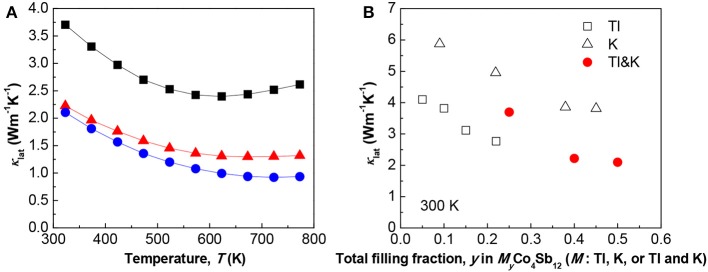
(A) Temperature dependence of the lattice thermal conductivity κlat of polycrystalline bulk samples of TlxK0.3Co4Sb12 (x = 0.1 − 0.3). (B) κlat at 300 K vs. the total filling fraction y in MyCo4Sb12 (M = Tl, K, or Tl and K). The data for Tl- and K-filled skutterudites were obtained from Harnwunggmoung et al. (2010) and Pei et al. (2006), respectively.